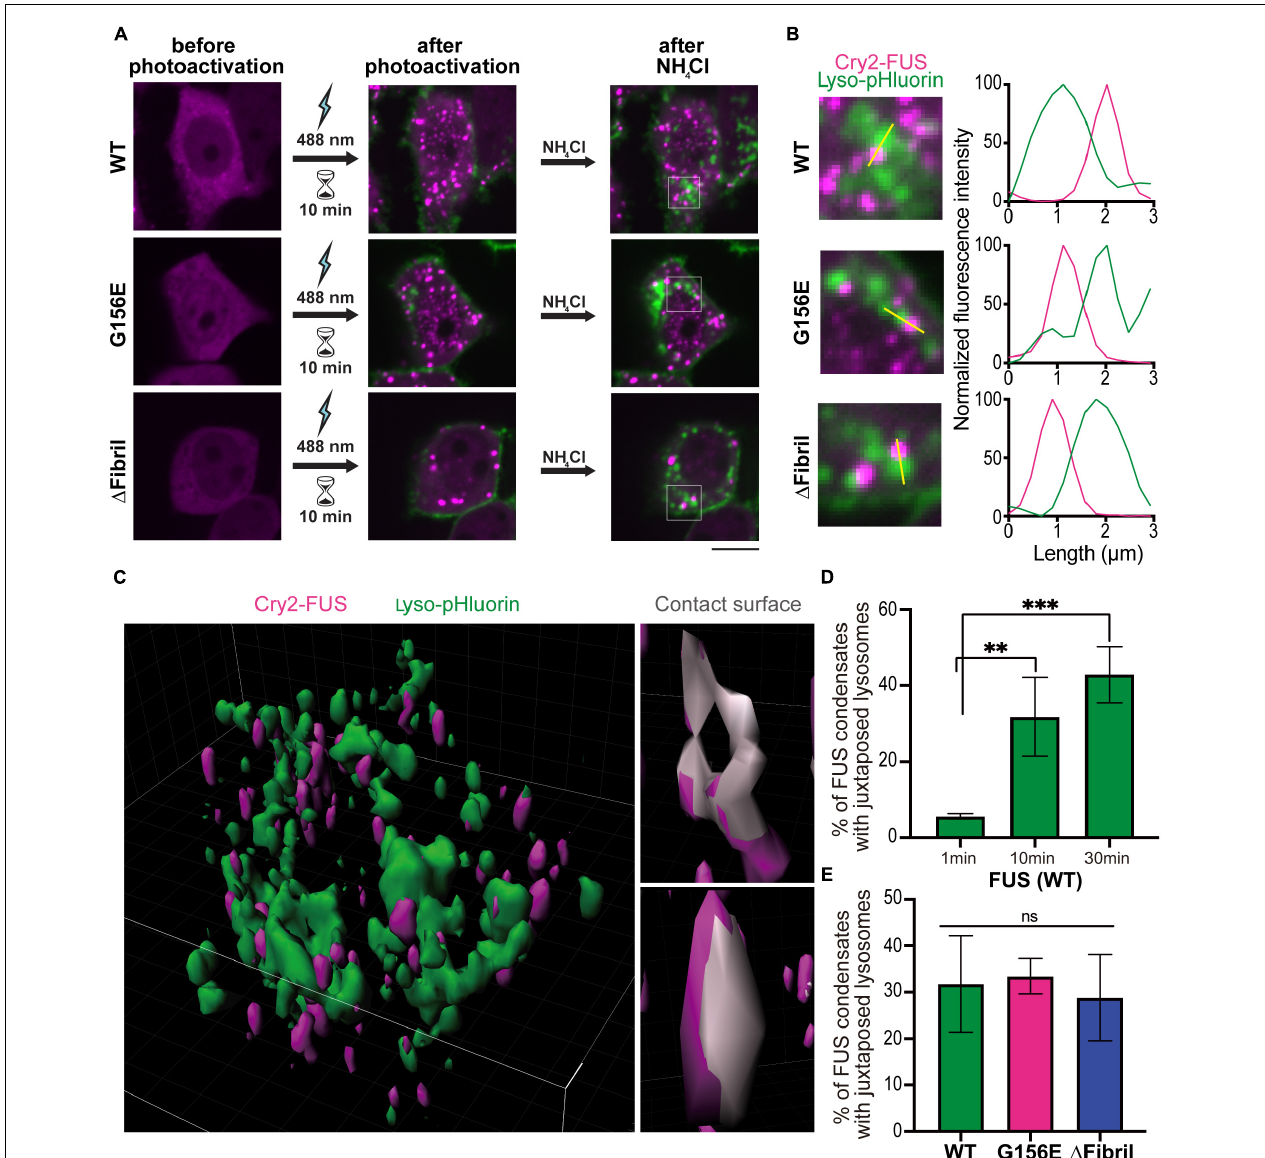
FIGURE 6 | Persistent photoactivation of FUS into solid-like condensates enhances lysosome sequestering. (A) Cells co-transfected with lyso-pHluorin and Cry2-FUS (top), Cry2-FUS G156E (middle), and Cry2-FUS (cid:49) Fibril (bottom) before (left) and after photoactivation with 488 nm-laser pulses (0.15 mW) for 10 min (middle). Subsequently, ammonium-chloride was added to alkalize the cells and allow for visualization of acidic lysosomes (right). Scale bar, 10 µ m. (B) Accumulation of lysosomes (lyso-pHluorin) juxtaposed to FUS condensates upon alkalization of cells. Left: magnified regions from images in (A) ; right: line profiles of the highlighted region indicated with yellow line. (C) Exemplary 3D reconstruction volume of lysosomes (lyso-pHluorin, green) and FUS condensates (Cry2-FUS, magenta). Left: Image of an entire cell; right: exemplary FUS condensates with the surface in contact with lysosomes highlighted in gray. (D) Colocalization of lysosomes (lyso-pHluorin) with FUS condensates increases with the duration of photoactivation ( ∗∗ P < 0.01, ∗∗∗ P < 0.001 two-sided, unpaired t -test; bars, standard error of the mean). (E) Both wild-type and mutated FUS sequences show a similar propensity for lysosome accumulation upon